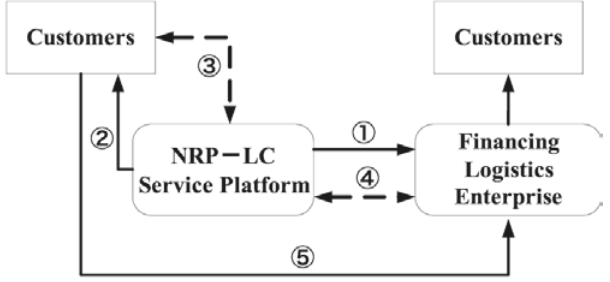
Figure 2: The logistics operation process (1 - information to large-scale enterprise; 2 - information to customer; 3 - feedback; 4 - feedback; 5 - Service provision and